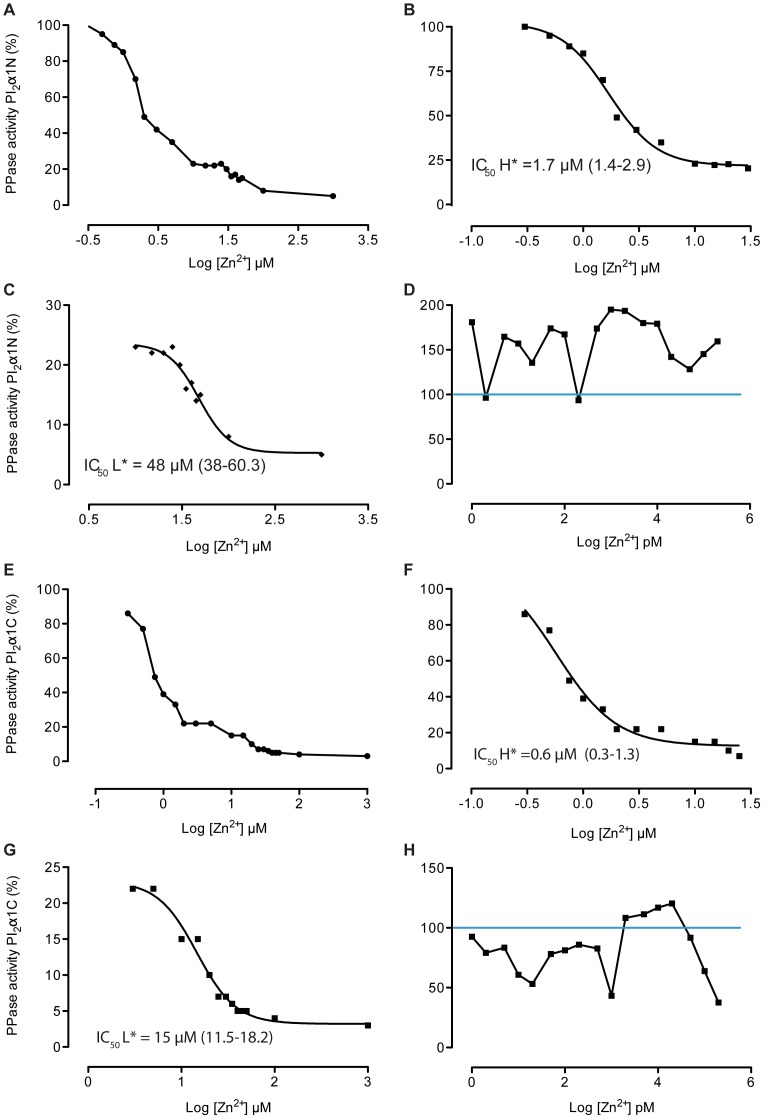
Inhibition profiles of the phosphatase (PPase) activities by Zn2+ ions using N-and C-terminal phosphopeptides as substrate.Assays were performed in presence of rat washed cortical membrane at 50 µg/ml of total protein concentration, with increasing amounts of Zn2+ ions in 10 mM Hepes buffer pH 7.4 with 1 mM Mg2+ in presence of. Incubations were performed at 30°C during 10 min. The activities are expressed as a percentage of that of control samples. (A) Total curve inhibition by Zn2+ (0.1 µM–1 mM) with pI2α1N-P at 10 µM as substrate, the curve could be fitted to a two-step mechanism: ‘H’ high affinity (B), and ‘L’ low affinity (C). (D) At very low Zn2+ concentrations (1 pM–200 nM) activation of PPase activity was observed. (E) Total curve inhibition by Zn2+ (0.1 µM–1 mM) in presence of pI2α1C-P at 10 µM, two affinities was observed: ‘H’ high affinity (F), and ‘L’ low affinity (G). (H) PPase activity at very low Zn2+ concentrations (1 pM–200 nM). The IC50 values are mentioned with their 95% confidence intervals and calculated from nonlinear regression curve fits using GraphPad Prism 5.